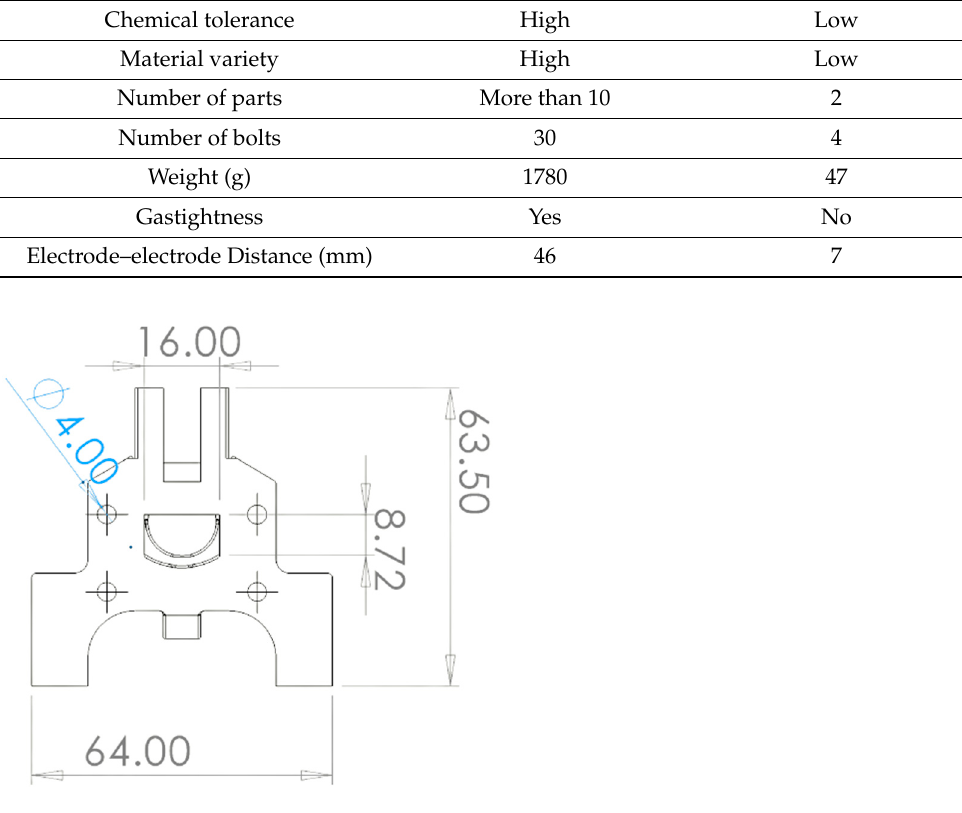
Figure 3. A 2D sketch of the final reactor prototype with its main dimensions in mm.